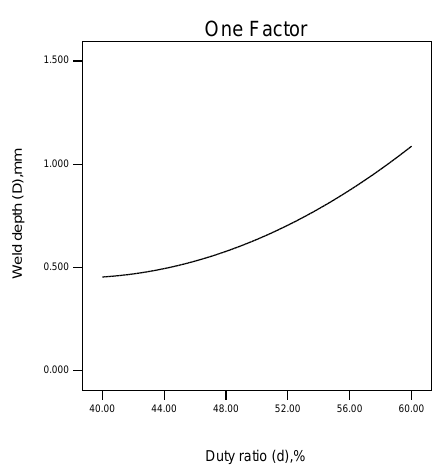
Figure 8. Influence of duty ratio on weld depth.